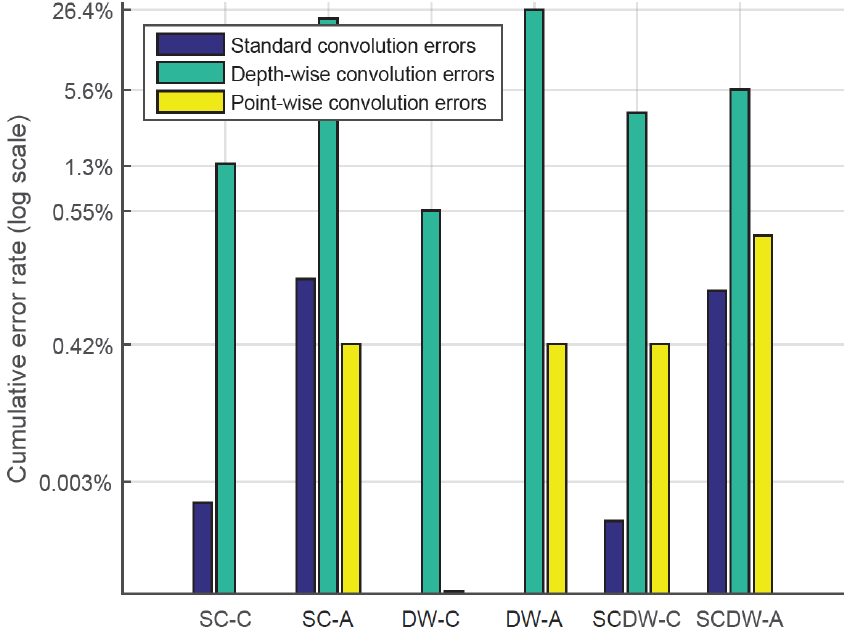
Figure 4. The observed error rate percentages for each layer type under different pruning configura-